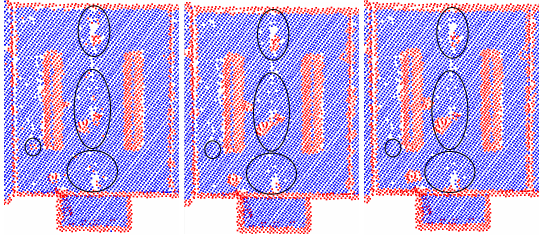
Figure 13. Results obtained using PCA on different k-nearest neighbour settings. The points of which the normal vector diverged more than 5 ◦ from the roof are shown in red colour. Figure 14. Comparison of selected performance indicators for While between settings 5 ◦ (left) and 10 ◦ (middle) differences the four setting exist (see zones inside black circles), they are minimal between 10 ◦ (middle) and 15 ◦ (right).